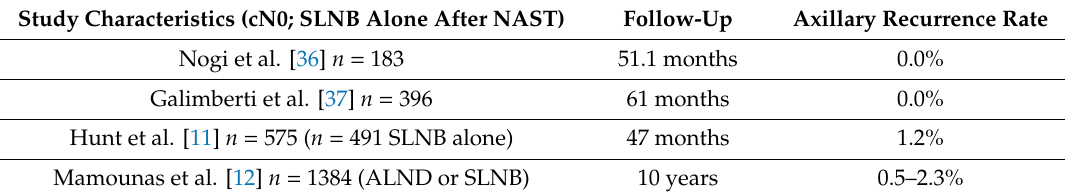
Table 2. Previous findings in neoadjuvant breast cancer trials with initially cN0 patients and axillary surgery after NAST with respect to axillary recurrence